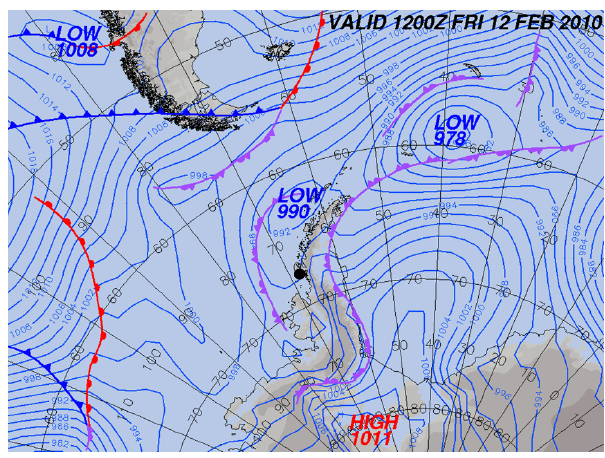
Fig. 1. The surface pressure chart for flight #104 on 12 Febru- ary 2010, 12:00UTC. The location of the British Antarctic Survey Rothera Station is also shown on the map with the black